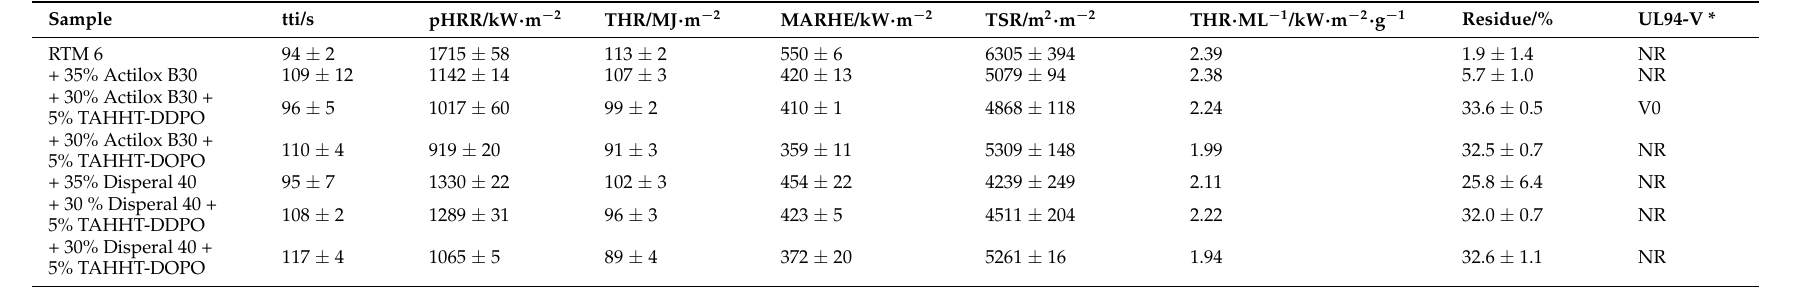
Table 10. Results of cone calorimetry and UL94 (sample thickness 4 mm) for depicted samples containing